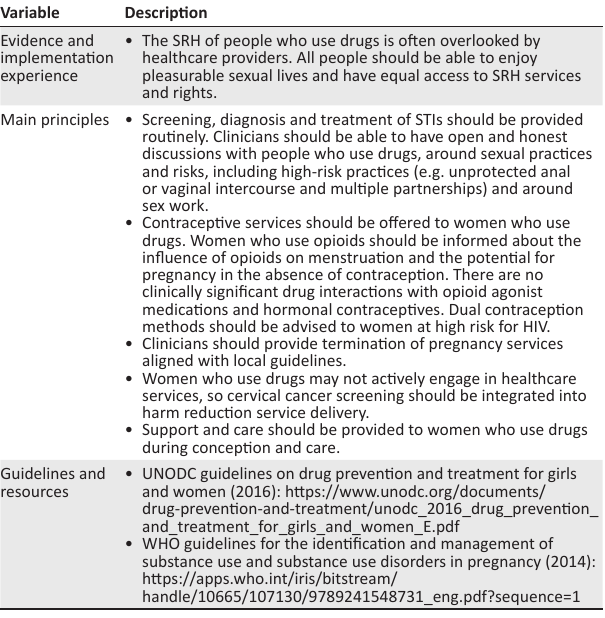
TABLE 24: Sexual and reproductive health services.